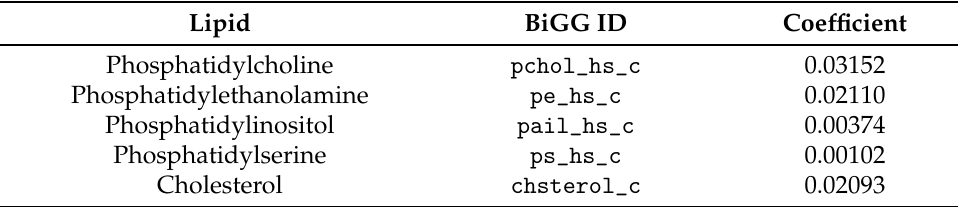
Table 1. Stoichiometric coefficients of the five lipids in the macrophage’s maintenance function. The stoichiometric coefficients of the five lipids were extracted from the macrophage’s maintenance function. Additionally, the BiGG identifiers [28] of the lipids are given. These stoichiometric coeffi- cients formed the starting point for evaluating the lipids’ influence on the viral biomass objective function